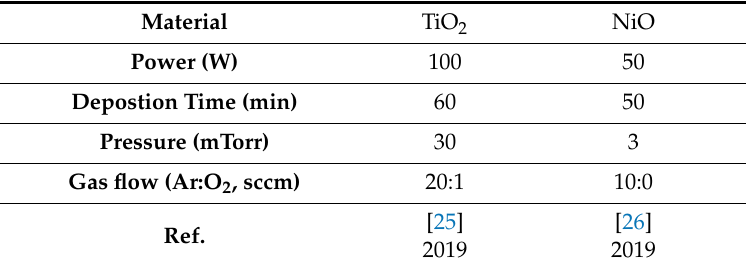
Table 1. Sputtering parameters for the different sensing matrices.